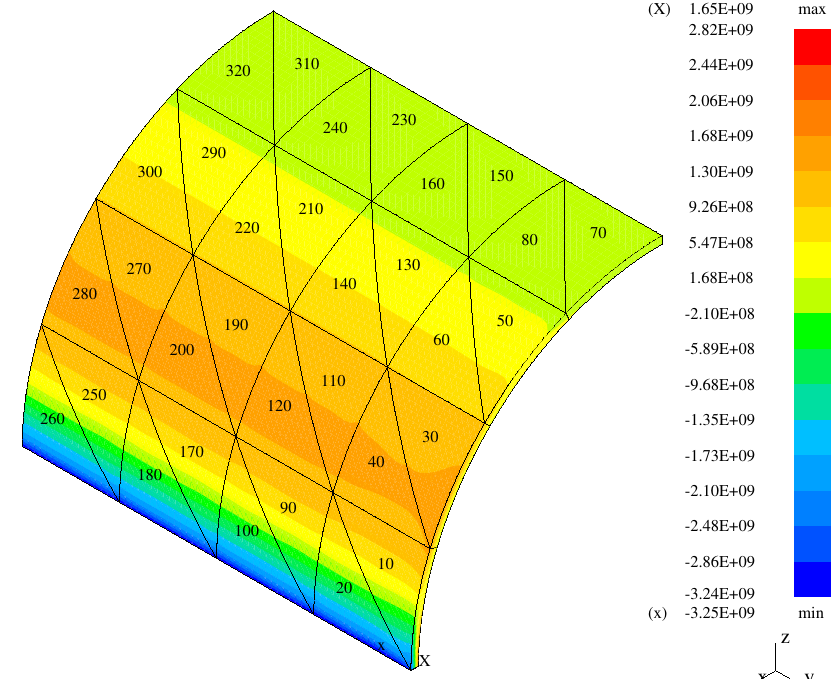
Figure 15. Third normal stress—the bent shell with the modified transition